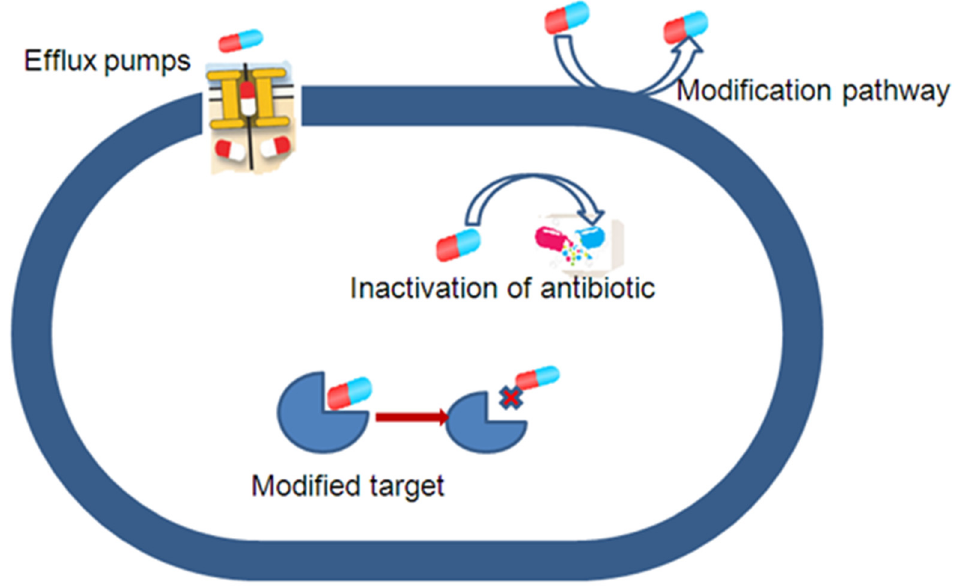
Figure 3. Major mechanisms of bacteria resistant to antibiotics (inspired from